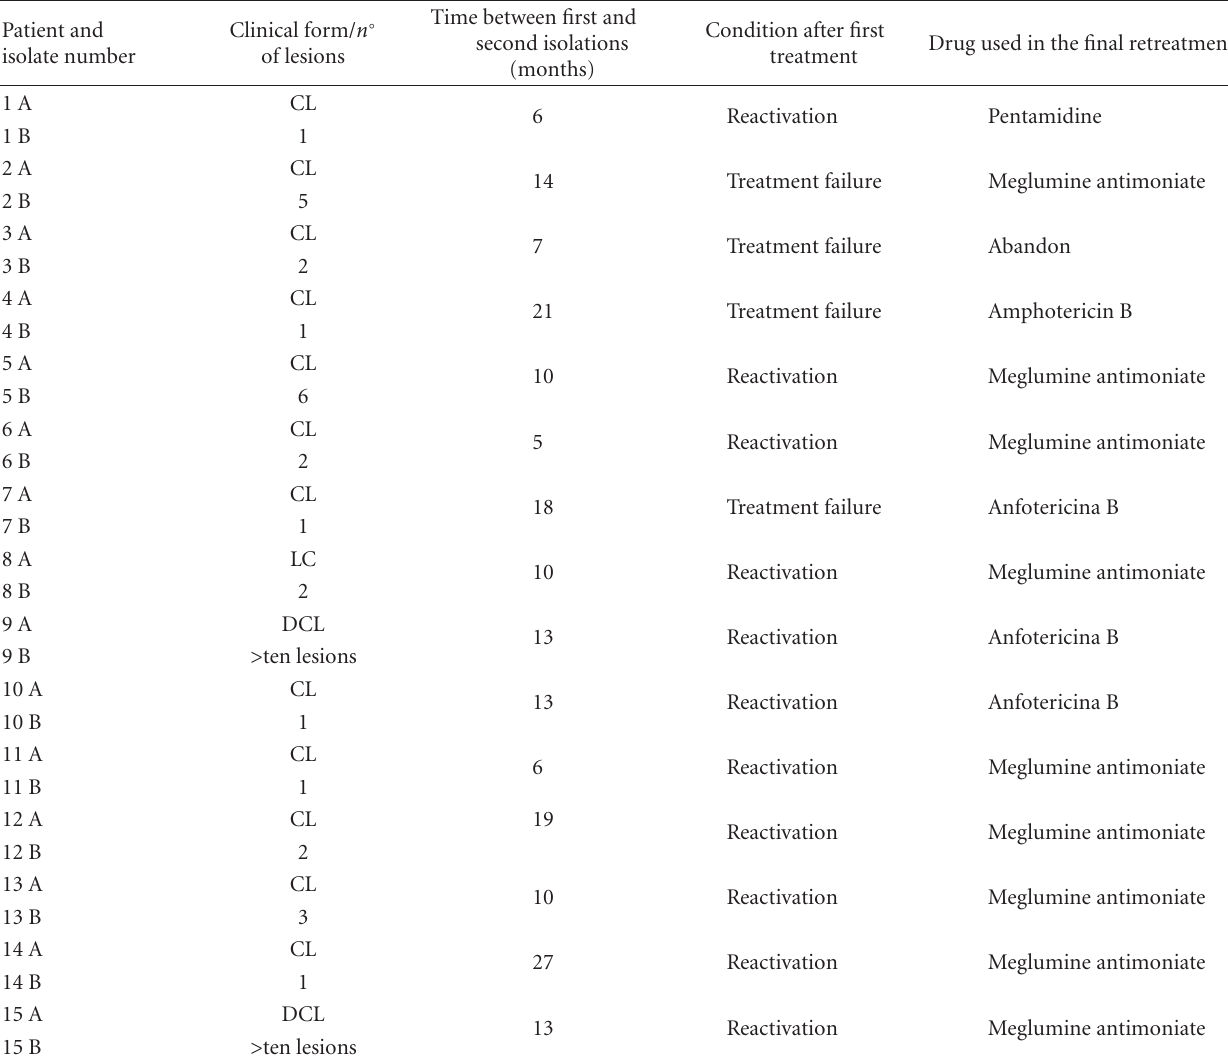
Table 1: Data from 15 patients with ATL with failure to treatment or